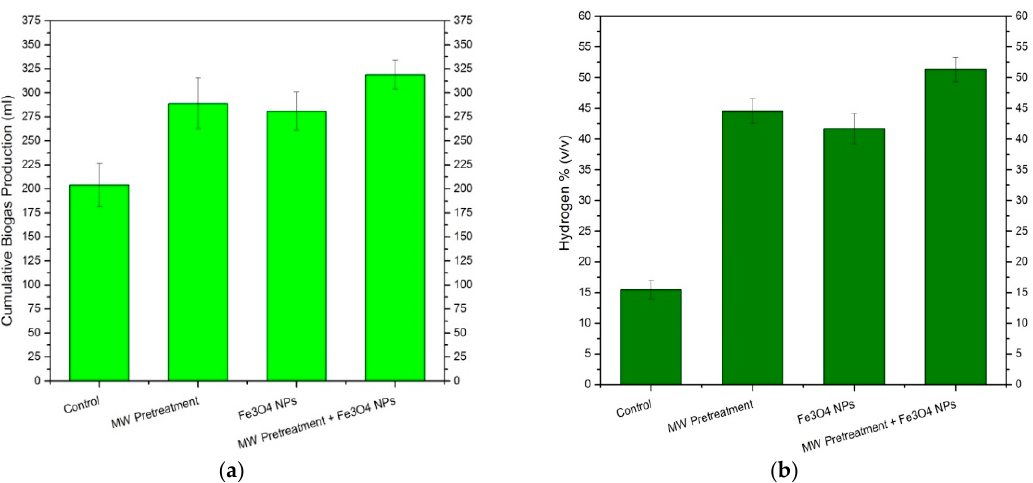
Figure 3. Cumulative biogas production ( a ) and hydrogen % v / v by different treatment conditions.